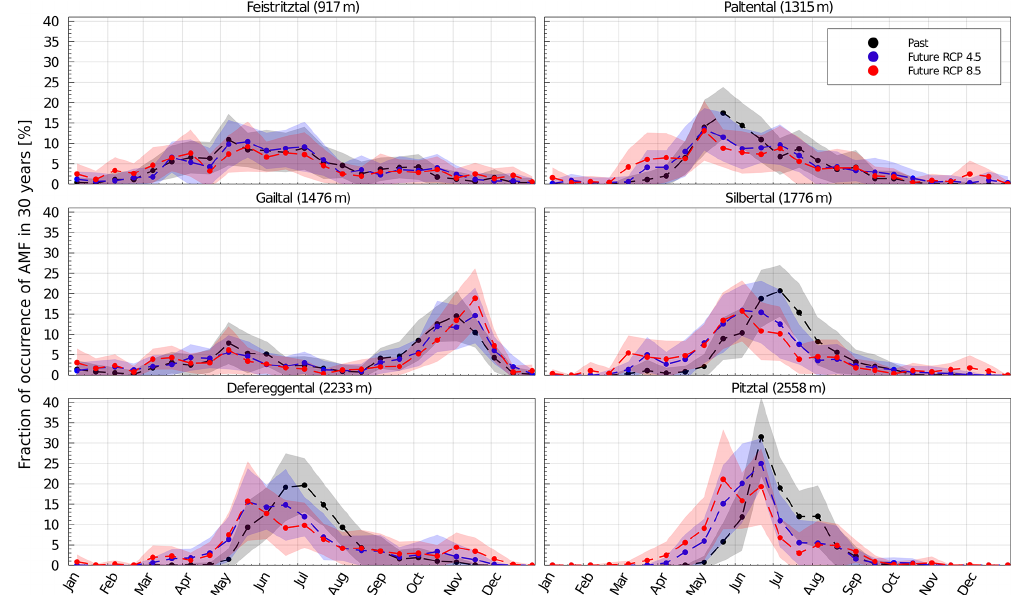
Figure 11. Mean fraction of occurrences of AMF in the past (black dots) and future (blue dots – RCP4.5; red dots – RCP8.5) for 30-year time periods, using time windows of 15d across all model simulations. The shaded areas indicate the associated ± 1SD. Dashed lines between the individual 15d periods are used for better visualization. Table 5. Mean and standard deviation of timing of annual maximum flow (AMF) across all simulations, based on the average timing of AMF over 30 years of each simulation. The dates are shown as the day of the year. For the past, the actual calendar date is given as a reference. Past ( d )